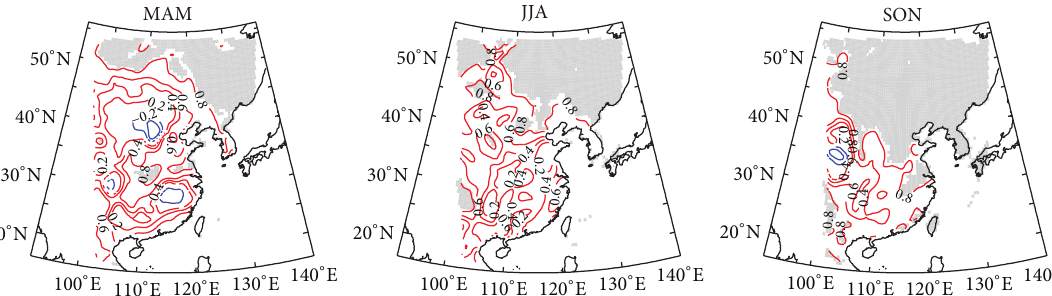
Figure 4: Correlations between observed and simulated interannual temperature from 2002 to 2009 for spring (March to May; MAM), summer (June to August; JJA), and autumn (September to November; SON) (shading denotes a confidence level higher than 99%; interval of contour lines is